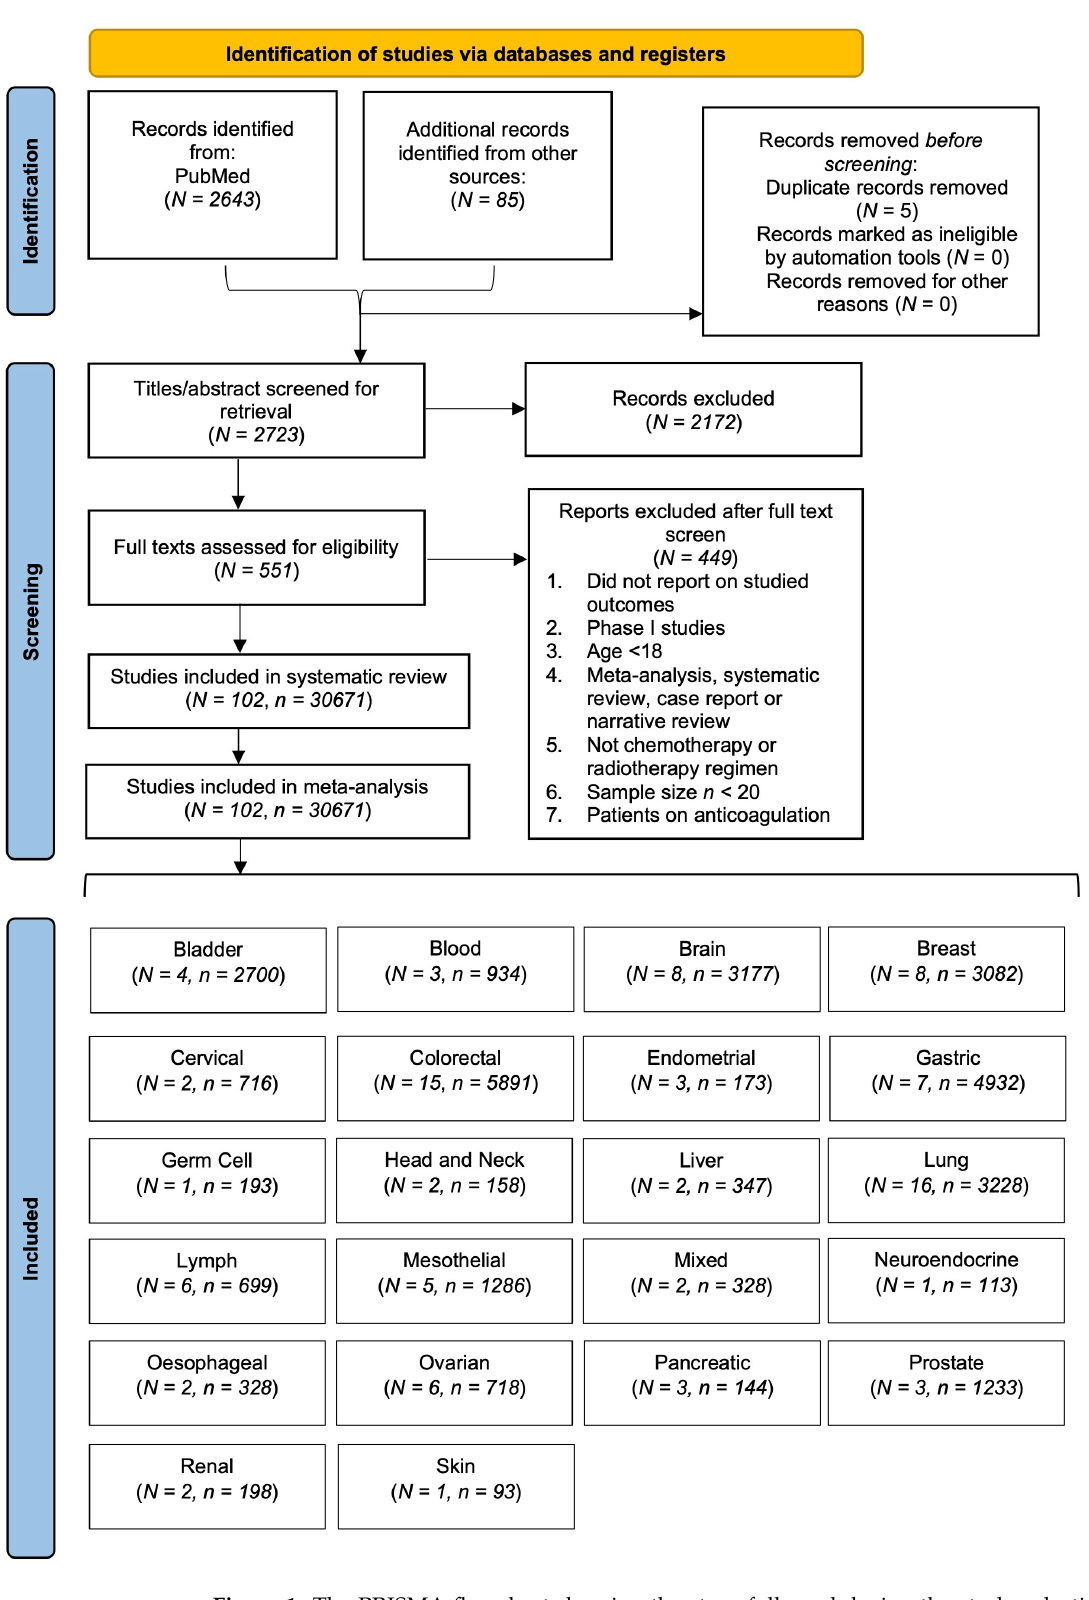
Figure 1. The PRISMA flowchart showing the steps followed during the study selection process. Abbreviations: N : number of studies; n : number of patients.